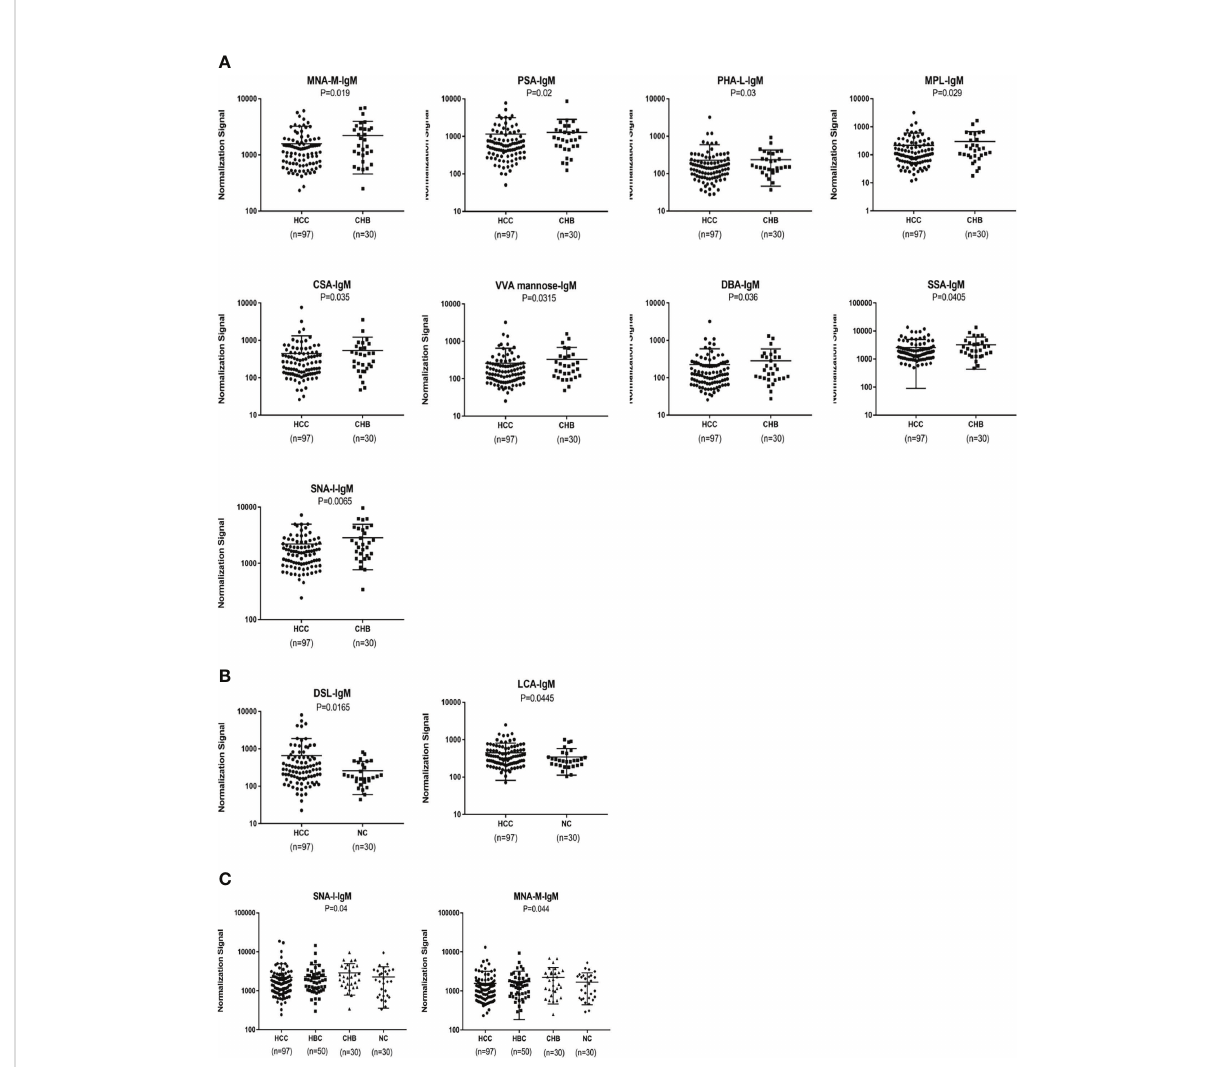
FIGURE 4 Speci fi c lectins of serum IgM determined by the lectin microarray. (A) Speci fi c differences in serum IgM glycosylation between HCC and CHB. (B) Speci fi c differences in serum IgM glycosylation between HCC and NC. (C) Speci fi c differences in serum IgM glycosylation among HCC, CHB, HBC, and NC.